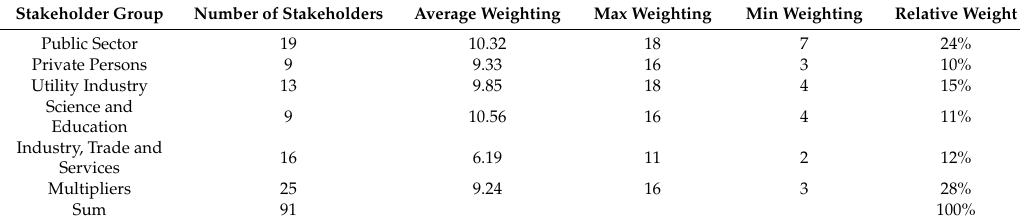
Table 2. Stakeholder group